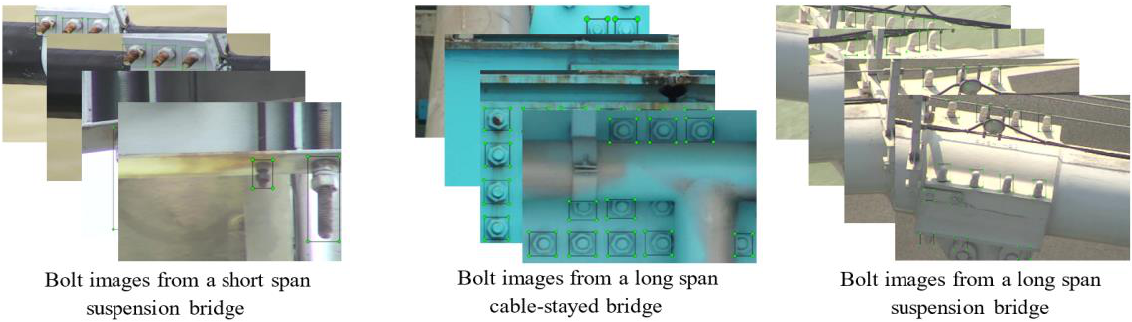
Figure 9. Examples of labeled images of the established dataset.